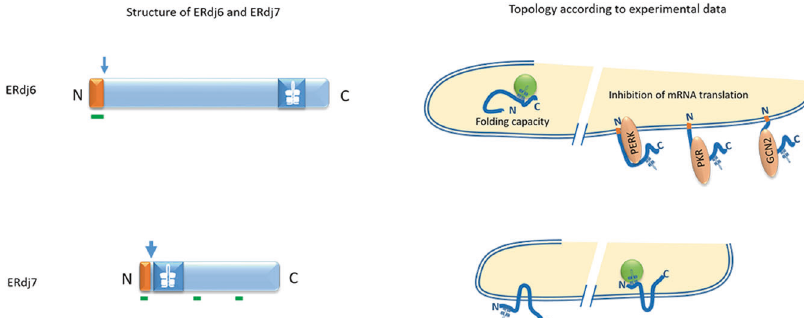
Fig. 4 Structure and topology of ERdj6 and ERdj7. Upper line: Computational analysis of ERdj6 predicts the presence of a signal sequence with a probability of 62%, the probability of its cleavage to be 32% (arrow), and a single transmembrane domain, which is located within the signal sequence. The experimental data point to cleavage of the signal sequence giving rise to a major, luminal free- fl oating ERdj6 protein pool, which catalyze ATPase activity of BiP to facilitate folding of luminal proteins [65, 72]. A minor Erdj6 pool remains uncleaved and inserts in a head-on formation as a type I transmembrane protein. In this topology, ERdj6 can physically interact and inhibit the kinase domain of PKR, PERK, and GCN2 thereby inhibiting phosphorylation of eIF2 α and promoting protein synthesis [65, 72]. Lower line: Computational analysis of ERdj7 predicts the existence of a signal sequence with a cleavage probability of 50% (arrow). Three putative transmembrane domains are predicted, the fi rst one is located within the signal sequence. No experimental data are available that investigated the orientation of ERdj7 at the ER membrane. Provided that the signal sequence is cleaved upon translocation and the existence of two membrane-spanning regions the topology could be as suggested in the diagram with the J-domain being either located luminal or cytosolic. Symbols used are described in Fig. Table 2. Topology and function of ERdj proteins.